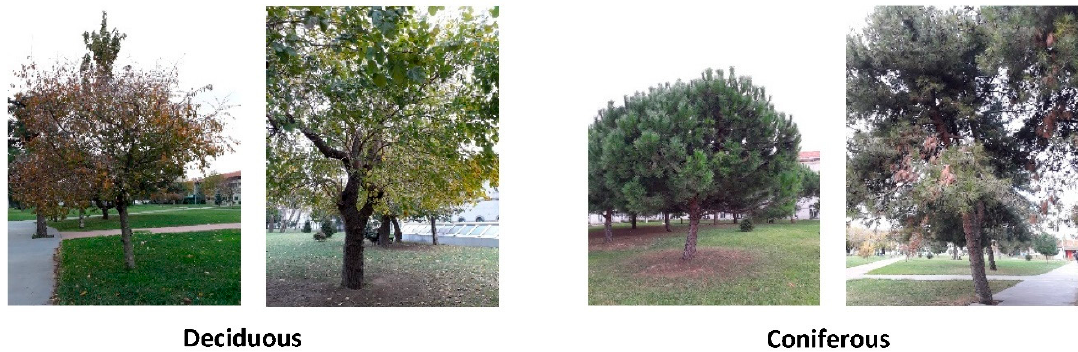
Figure 2. Deciduous and coniferous tree species in the urban study area.